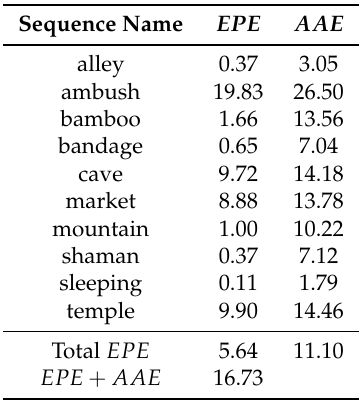
Table 13. Summary of results. The end point error and average angular error obtained by locations on maximum gradients in the MPI-Sintel training set.